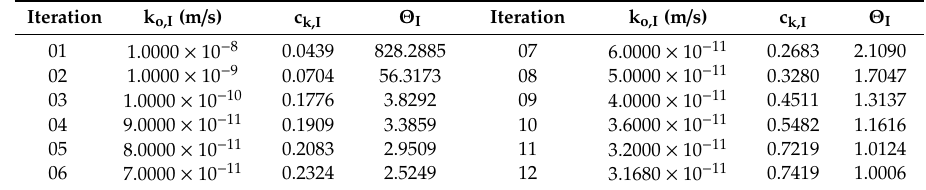
Table 7. Second application. Partial results of k o,I , c k,I and Θ I throughout the iteration process.